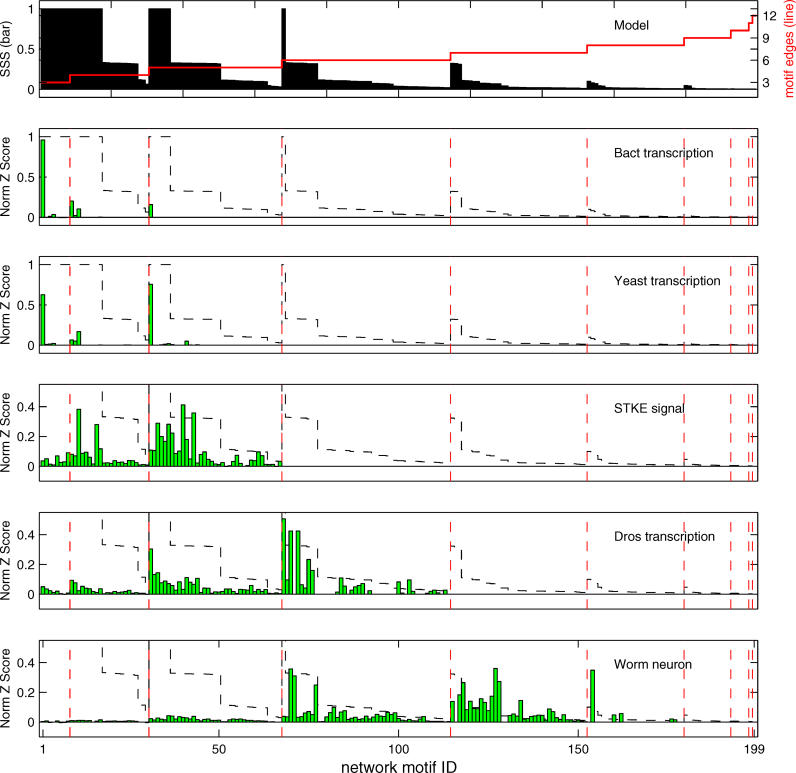
Distribution of Normalized Z Scores of Four-Node Network Motifs(Top panel) All 199 motifs are sorted on the x-axis first, according to increasing number of edges (solid red line). For a given number of edges, they are then sorted from high to low SSS (black bars).(Bottom five panels) Normalized Z scores (green bars) for all 199 network motifs of the indicated biological networks, shown with outlines of the SSS from the top panel (dotted black outline provided as a guide to the eye). Each vertical red line indicates a change in the number of motif edges, indicating boundaries of density groups. The composition of the four-node density groups is specified in Protocol S1.